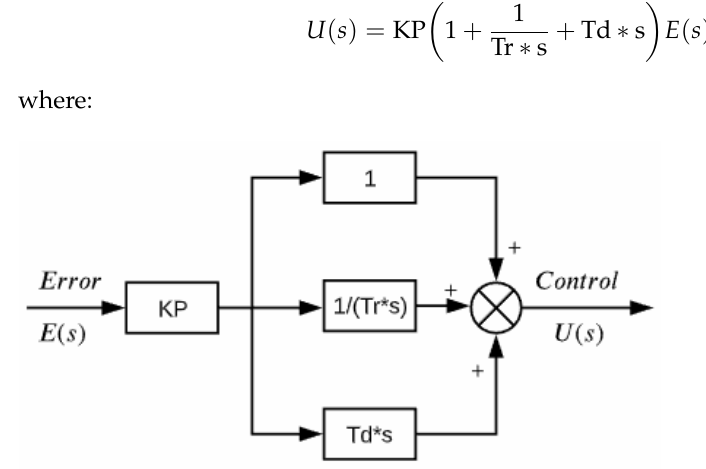
Figure 8. General structure of a PID controller.